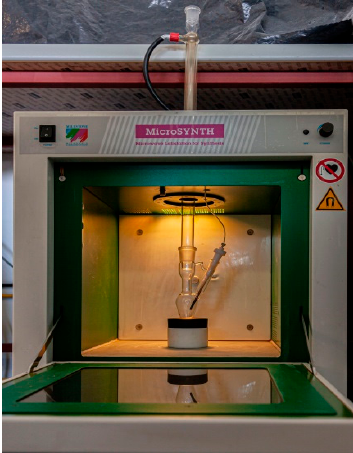
Figure 1. Experimental apparatus for microwave-assisted synthesis of chalcone derivatives.